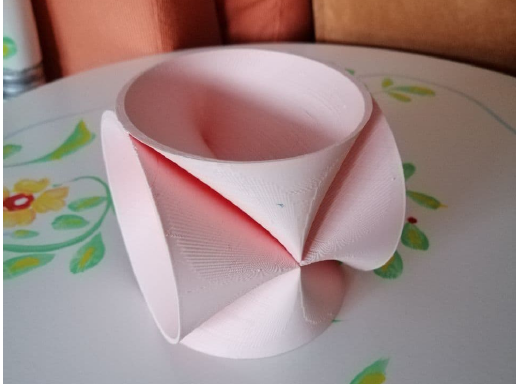
Figure 35. The Dyosphera in 3D print, detail of interlocks.